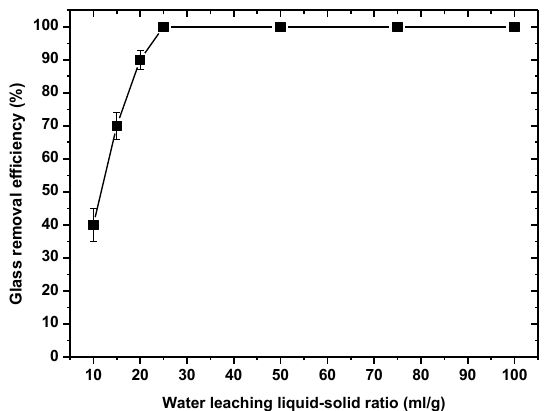
Figure 9. Effect of liquid – solid ratio on glass removal efficiency (experimental conditions: abrasive – glass polishing waste: approximately 1 g; roasting temperature: 450 °C; mass ratio of polishing waste to NaOH: 1:1; roasting time: 30 min; water leaching pH: 3, leaching temperature: 25 °C).